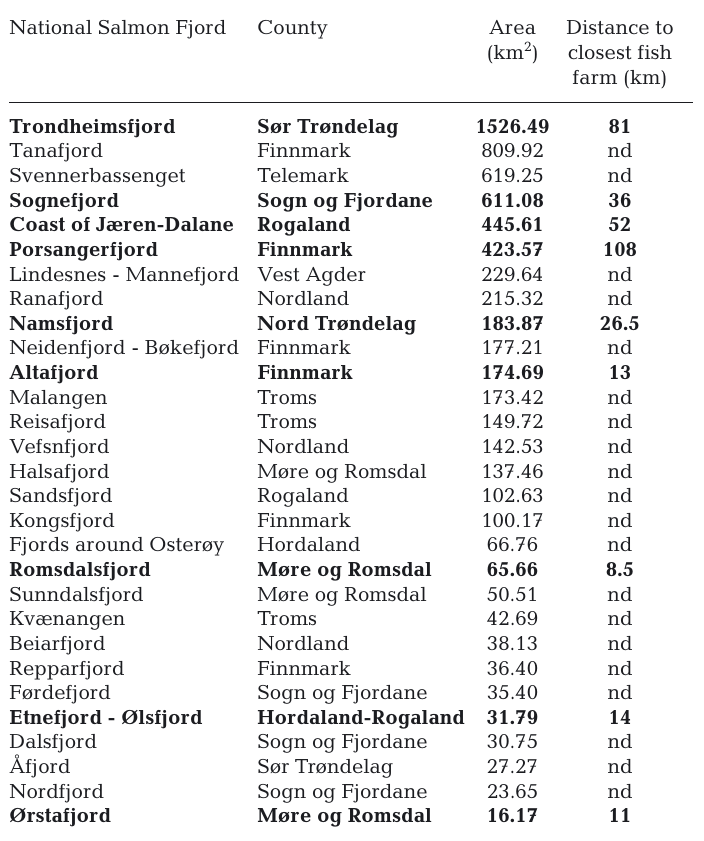
Table 1. National Salmon Fjords (n = 29) currently found in Norway organ- ized by size (km 2 ). Fjords where wild sea trout were sampled at least once as a part of the national sea lice monitoring program are highlighted in bold , and the distance between the sampling location and the closest fish farm (sea-way distance) is specified; no data (nd) is indicated